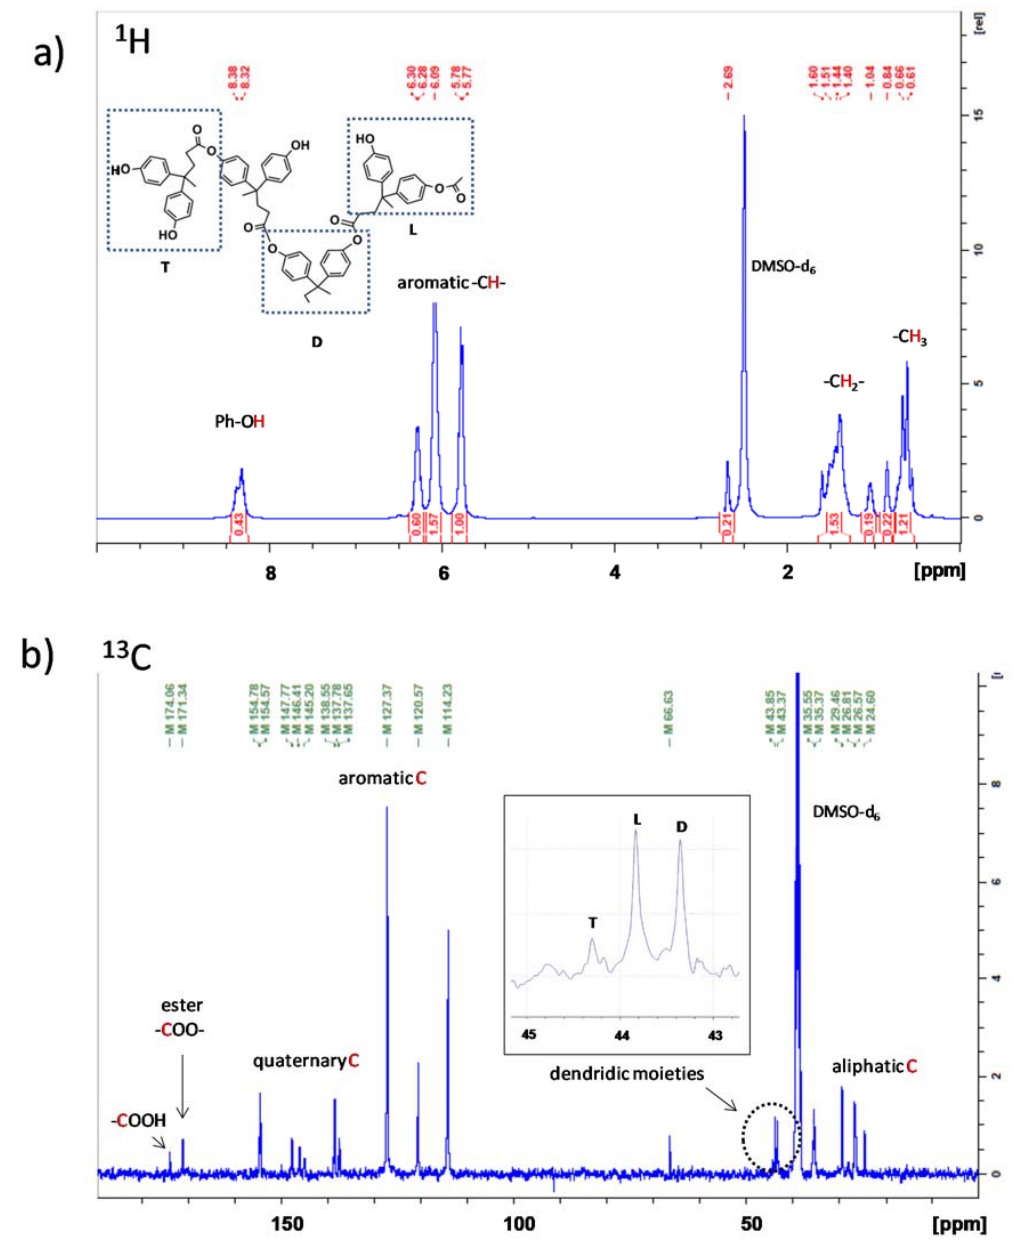
Figure 6. ( a ) 1 H and ( b ) 13 C NMR spectra of synthesized AHBP.